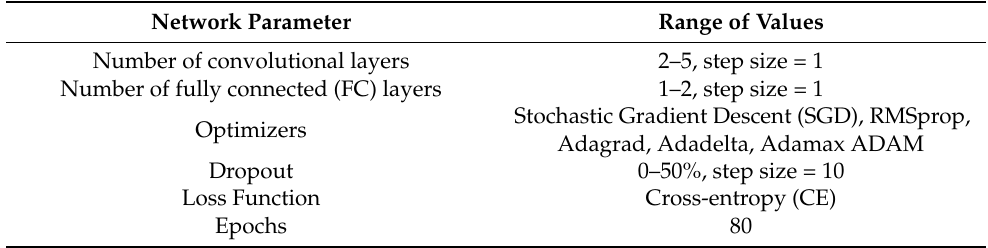
Table 1. Networks were trained with all combinations of parameters and the top three networks in terms of validation set accuracy were included in the final ensemble